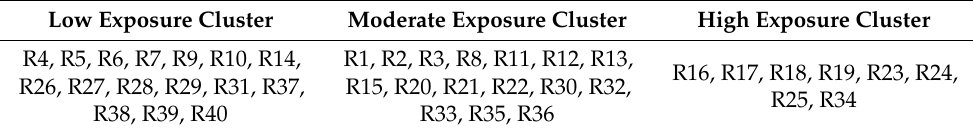
Figure 2. Differentiators (%) of the three clusters of restaurants based on average. Table 15. Assignment of restaurants to clusters using the proposed